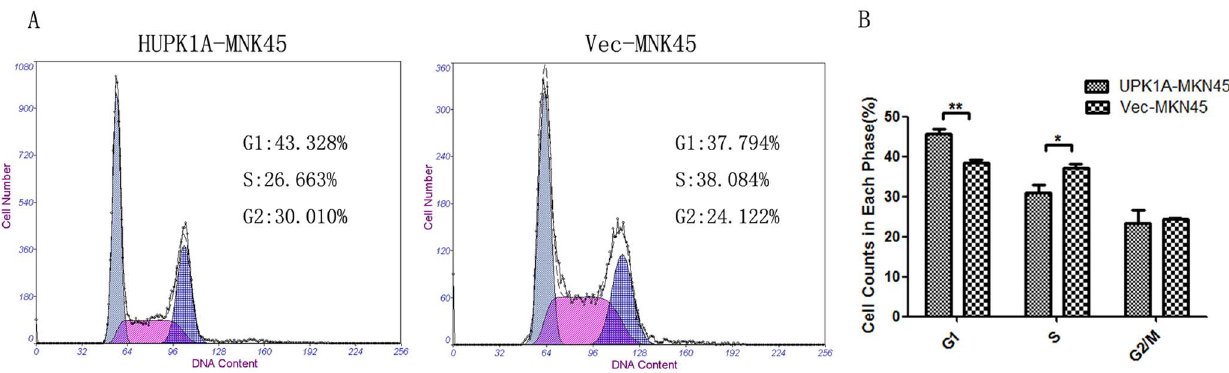
Figure 7. UPK1A overexpression caused G1-S checkpoint arrest in the MKN45 cells. A, The DNA content of Vec-510 and UPK1A-510 cells were compared by flow cytometry. B, The cell proportions from different phases were summarized. The results are expressed as the mean 6 SD of three independent experiments. *, P , 0.05, **P , 0.01.